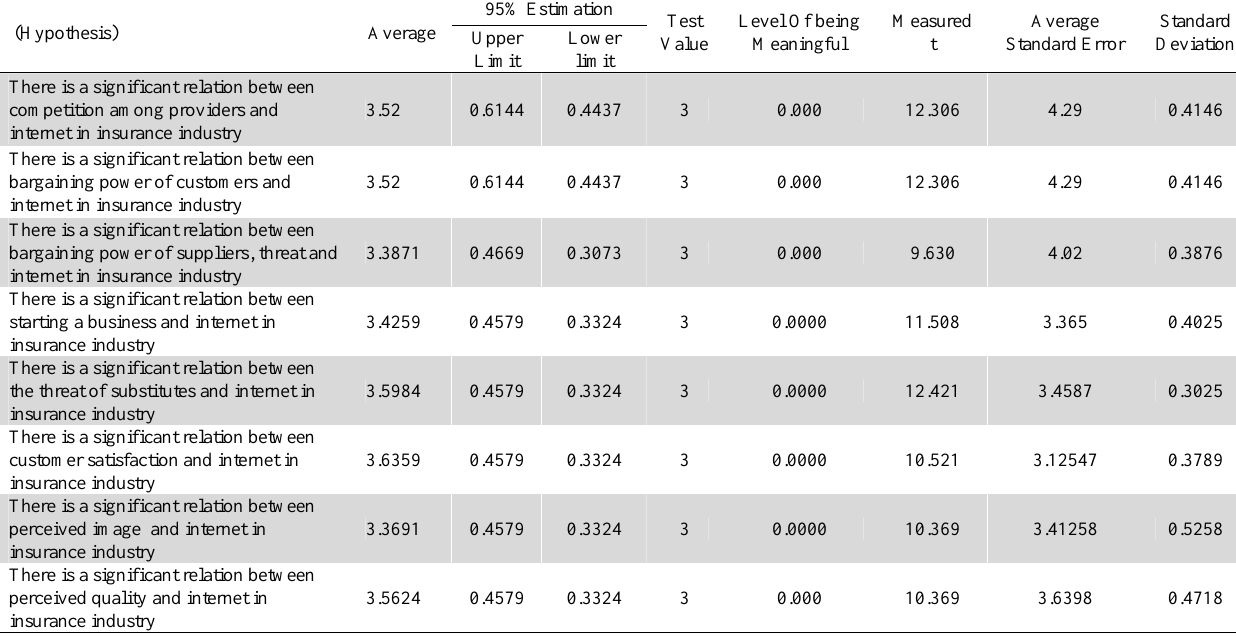
Statistical measures to test the